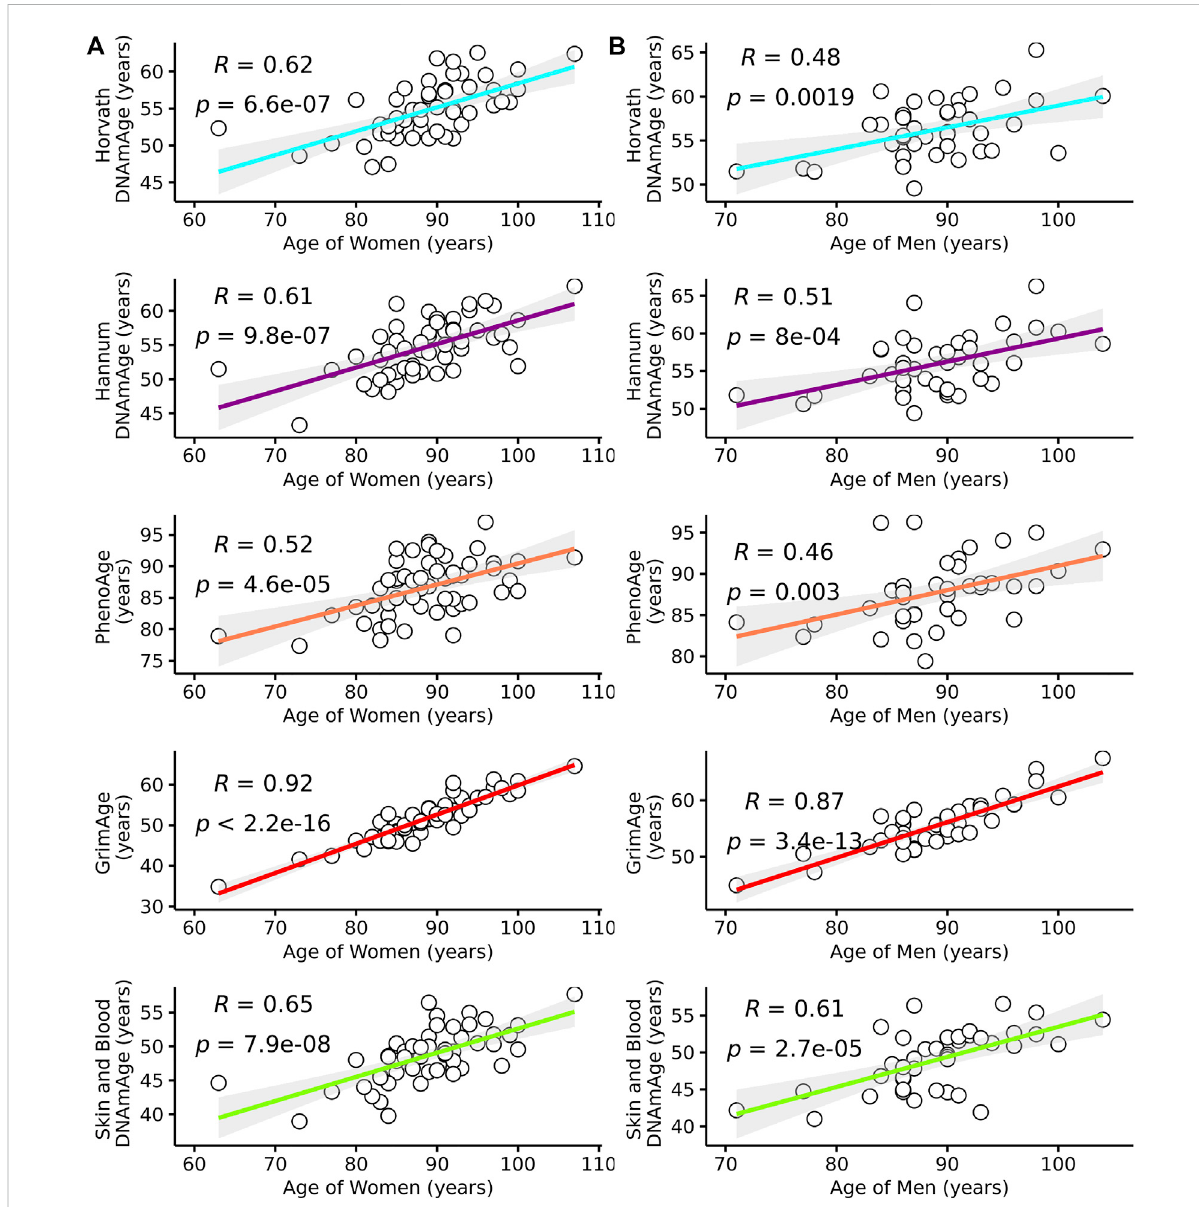
FIGURE 1 Pearson ’ scorrelationcoef fi cients( r )betweenpredictedepigeneticageandchronologicalageforseveralepigeneticclocksin (A) Femaleand (B) Male residents of the Mediterranean Blue